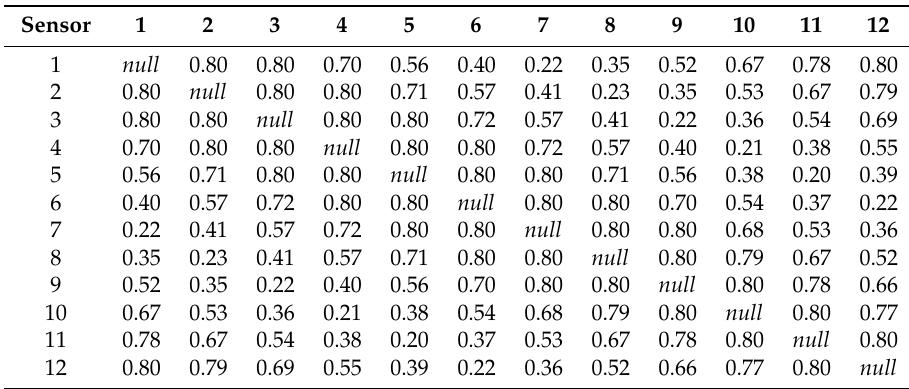
Table 1. The simulation input data of sample